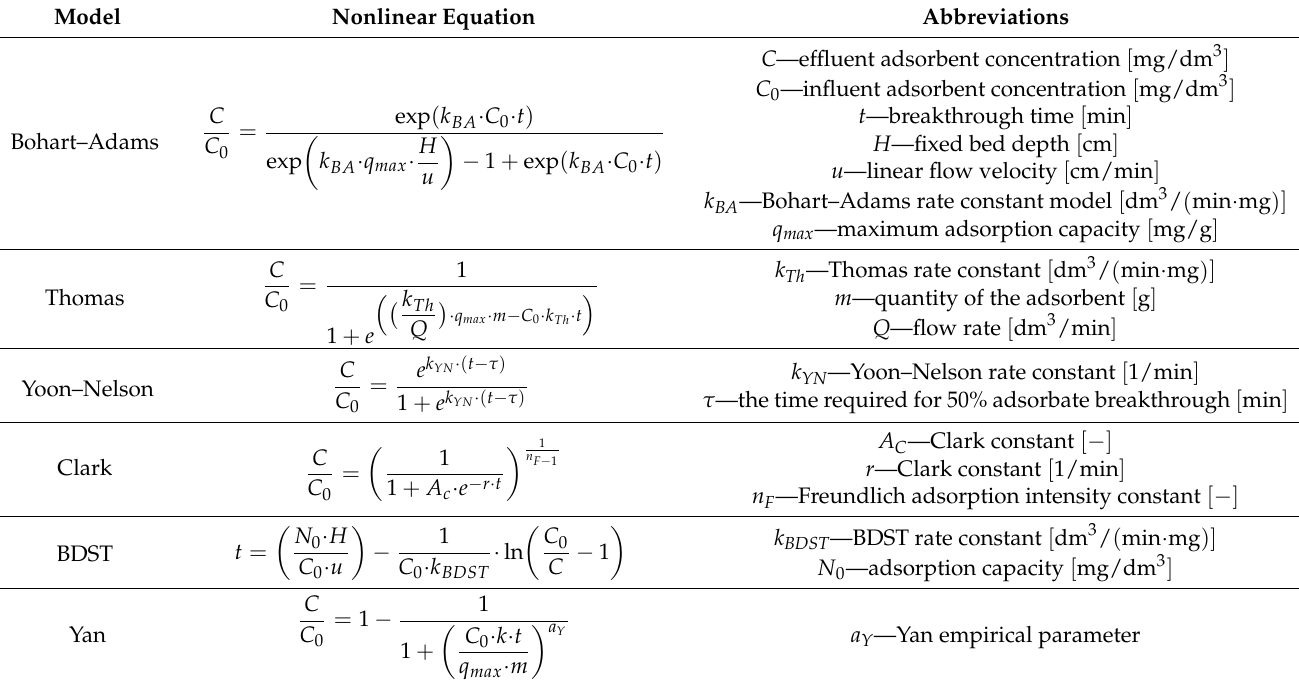
Table 3. Equations and parameters of dynamic models of the process of sorption of mercury ions on the